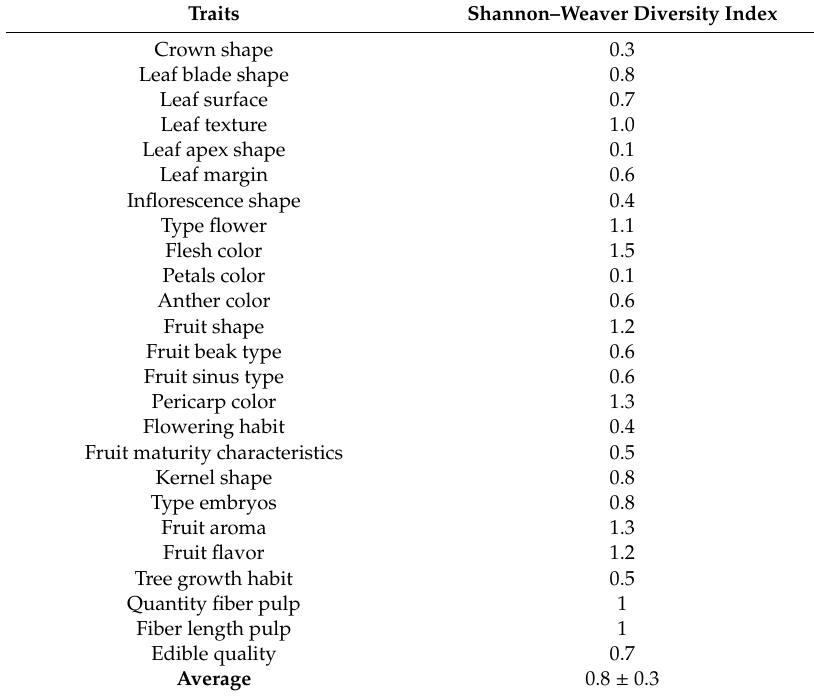
Table 1. Diversity of qualitative traits in the germplasm as revealed by Shannon–Weaver index.